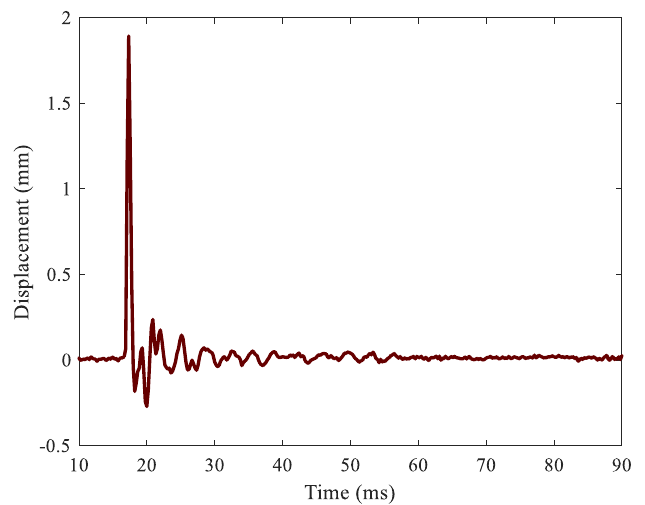
Figure 6. Vibration response at a point in the impacted area in absolute time after the start of recording. Simultaneous multihits are noticed as only one peak.